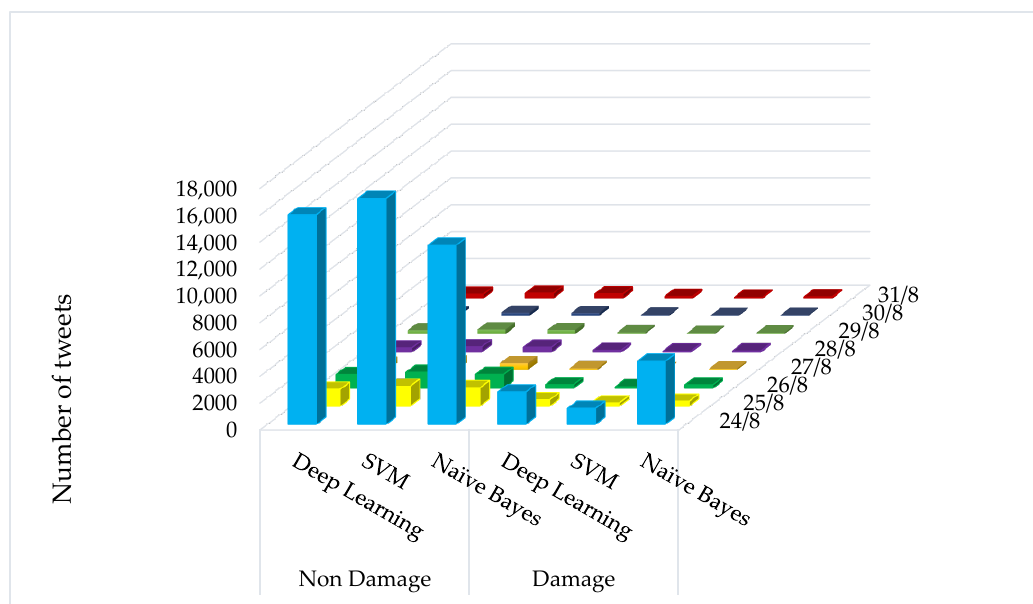
Figure 4. Number of tweets classified using the three, classification algorithms, Naive Bayes , SVM and deep learning, in damage and non-damage classes on each day one week after the earthquake.